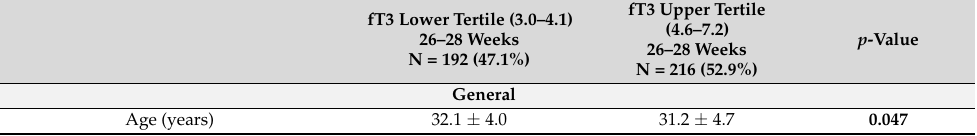
Table 4. Distribution of selected patient characteristics according to lower and upper tertiles of